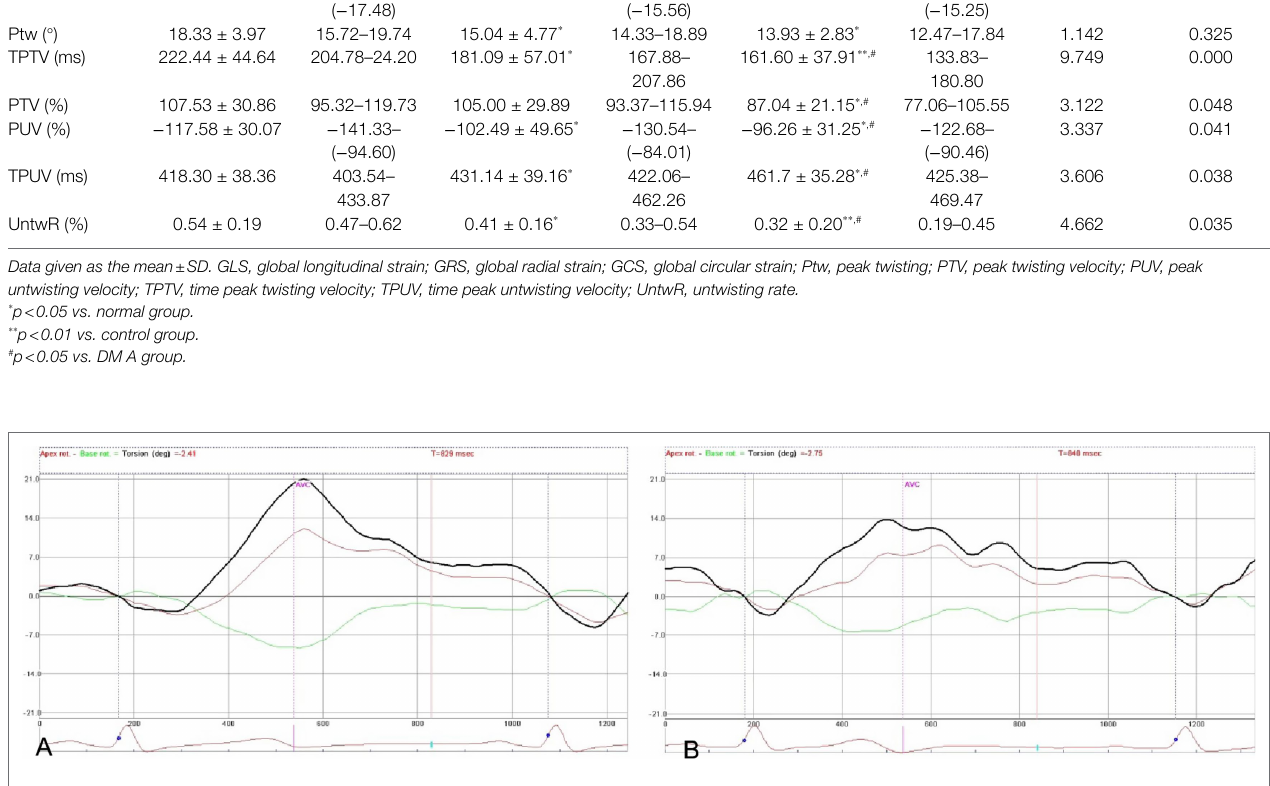
FIGURE 1 | The twisting and untwisting curves: (A) is the control group, and (B) is the DM